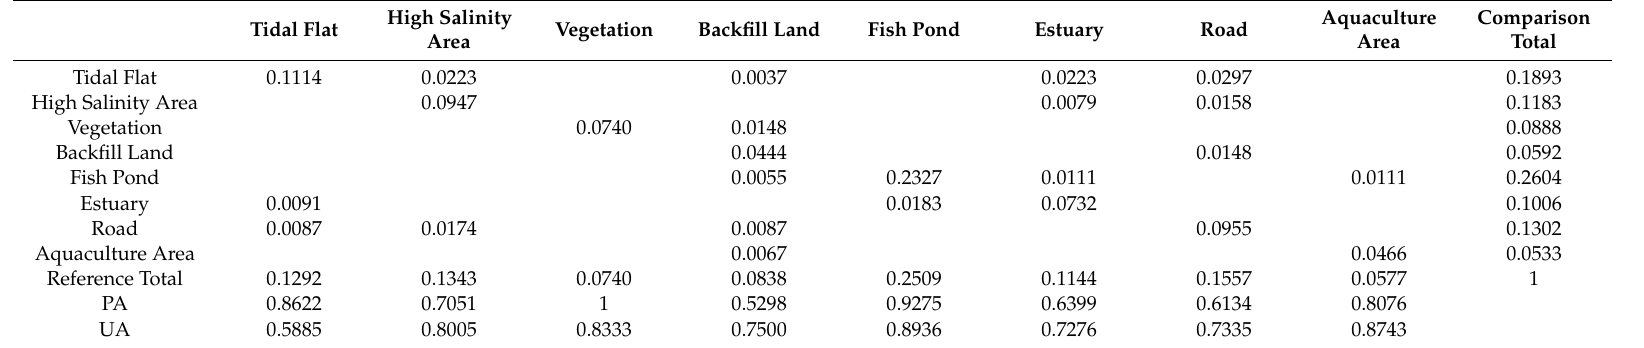
Table 12. Estimated population matrix of the k-NN method in the Landsat-8